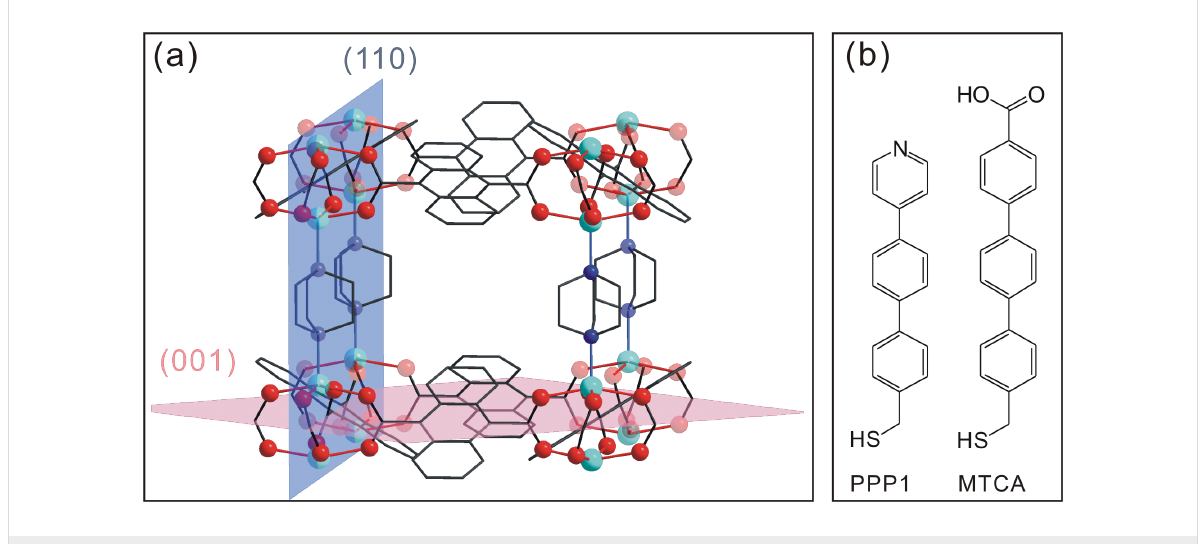
Figure 1: (a) The crystallographic cell of [Zn 2 (adc) 2 (dabco)]. The directionality of the attachment of carboxylate and monodentate Lewis bases (dabco/pyridine) determines the two crystallographic planes given in the scheme. (b) SAM-forming molecules used in this study.